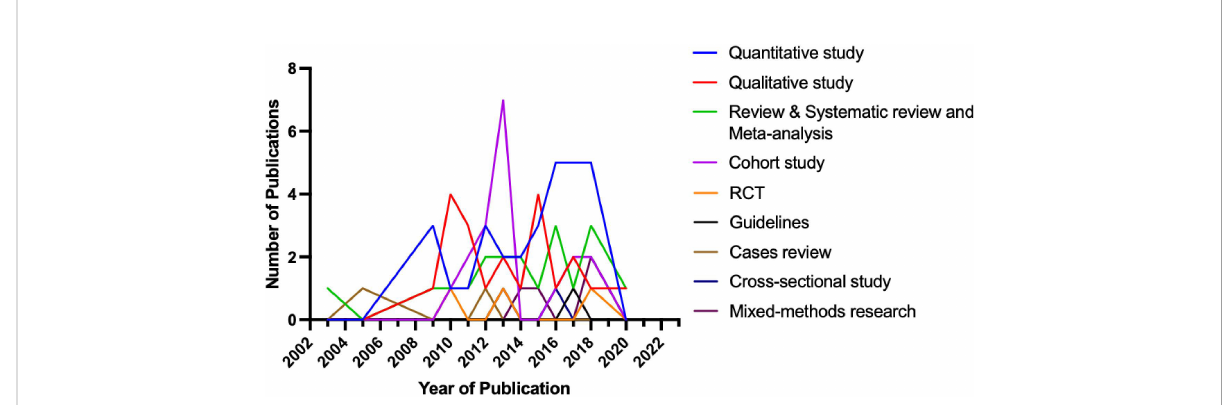
FIGURE 5 The top 100 cited article categories based on the research